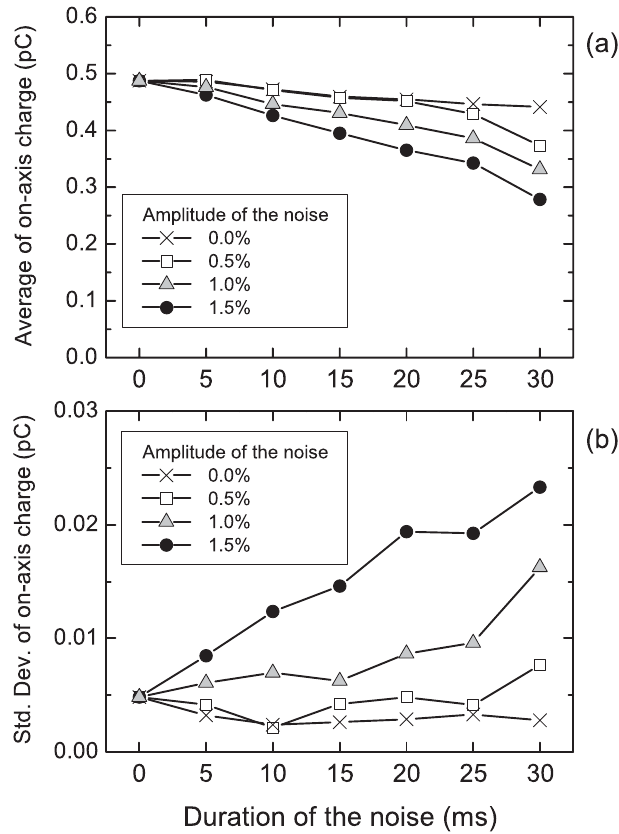
FIG. 4. Time history of (a) the statistical average, and (b) the standard deviation of the on-axis charge computed over an ensemble of 20 random error samples.